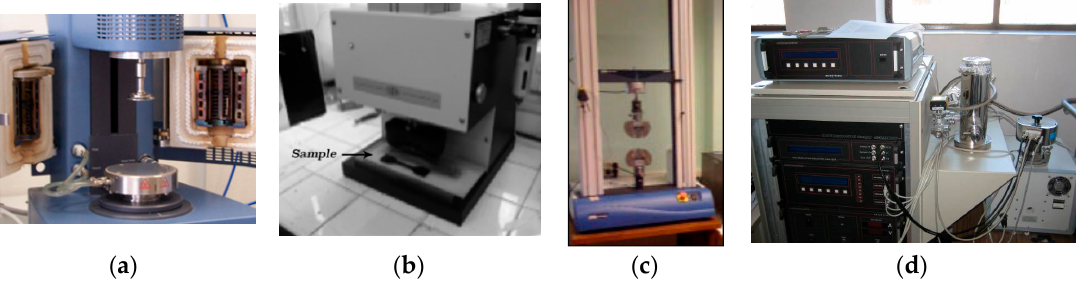
Figure 4. ( a ) Brabender mixer machine. ( b ) Specimen stamp machine. ( c ) Stress–strain tests, ( d ) Dielectric test.